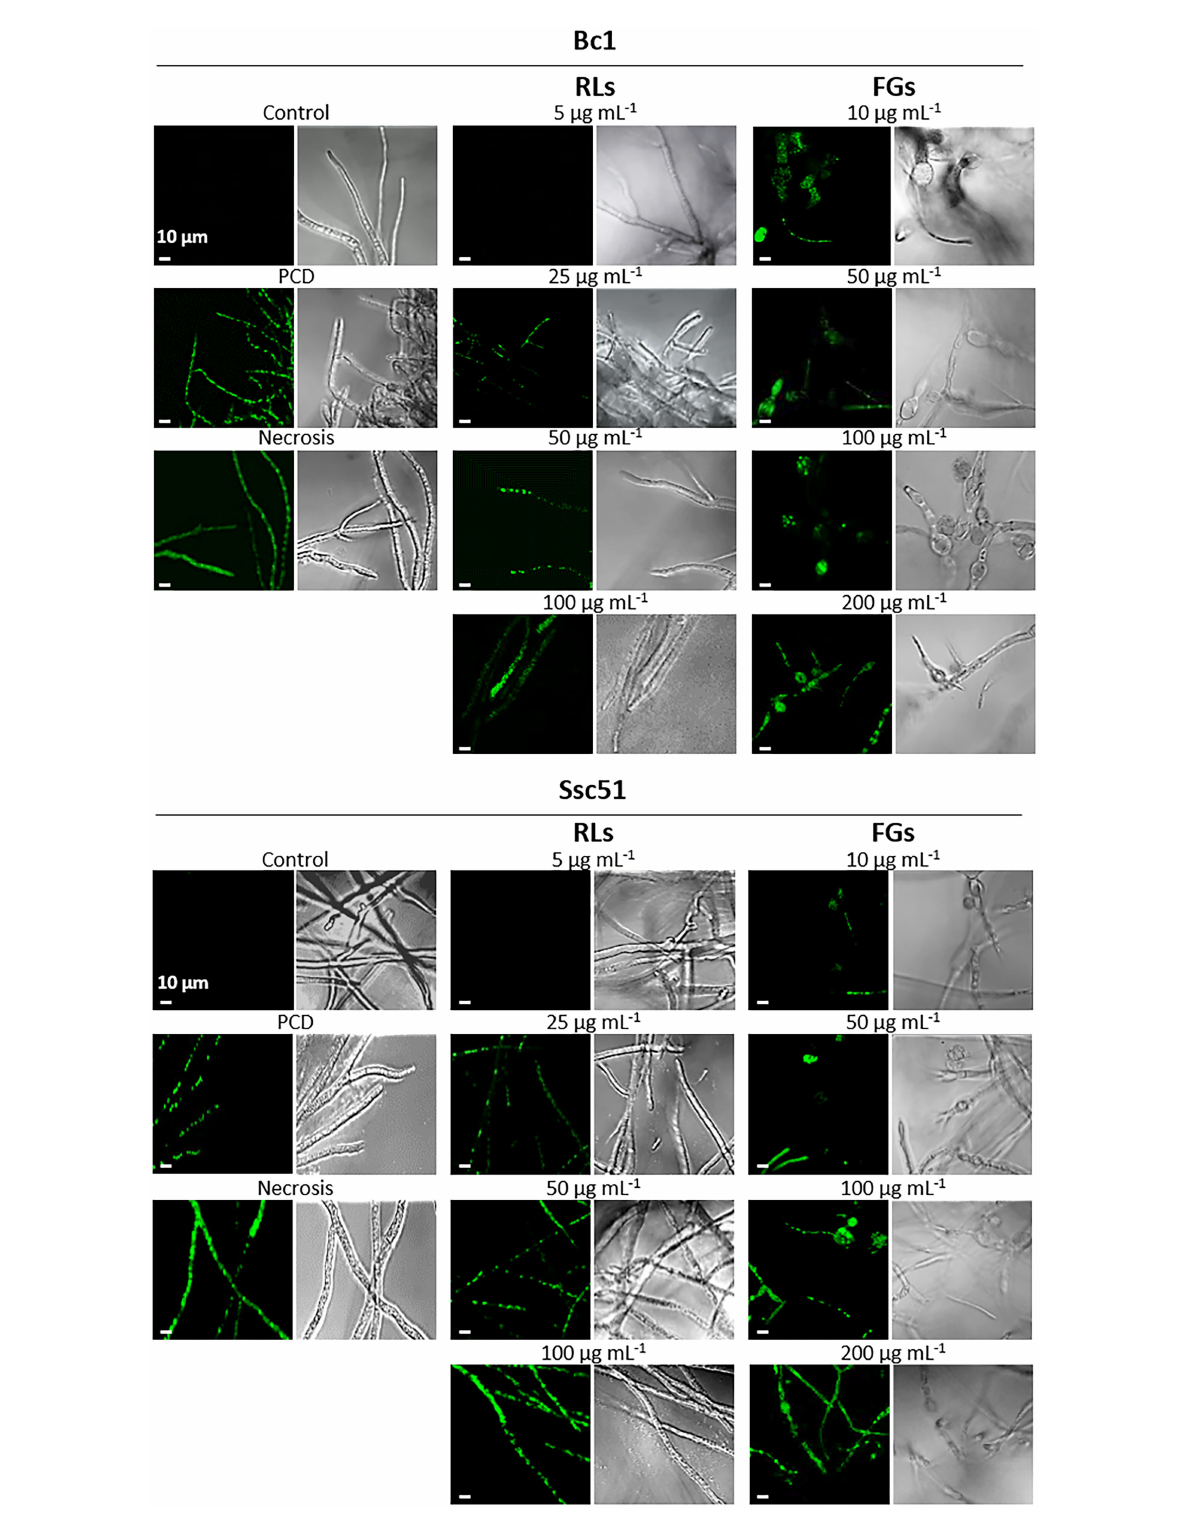
FIGURE 5 Permeabilization of mycelial cells by RLs or FGs. Confocal fluorescence microscopy observations of B. cinerea and S. sclerotiorum mycelium after treatments with different concentrations of RLs or FGs. PCD corresponds to mycelium treated with 3 mM hexanoic acid; necrosis corresponds to boiled mycelium. Cells were stained with SYTOX Green. Left panels are fluorescence microscopy images, right panels are light microscopy images. Scale bar: 10 μ